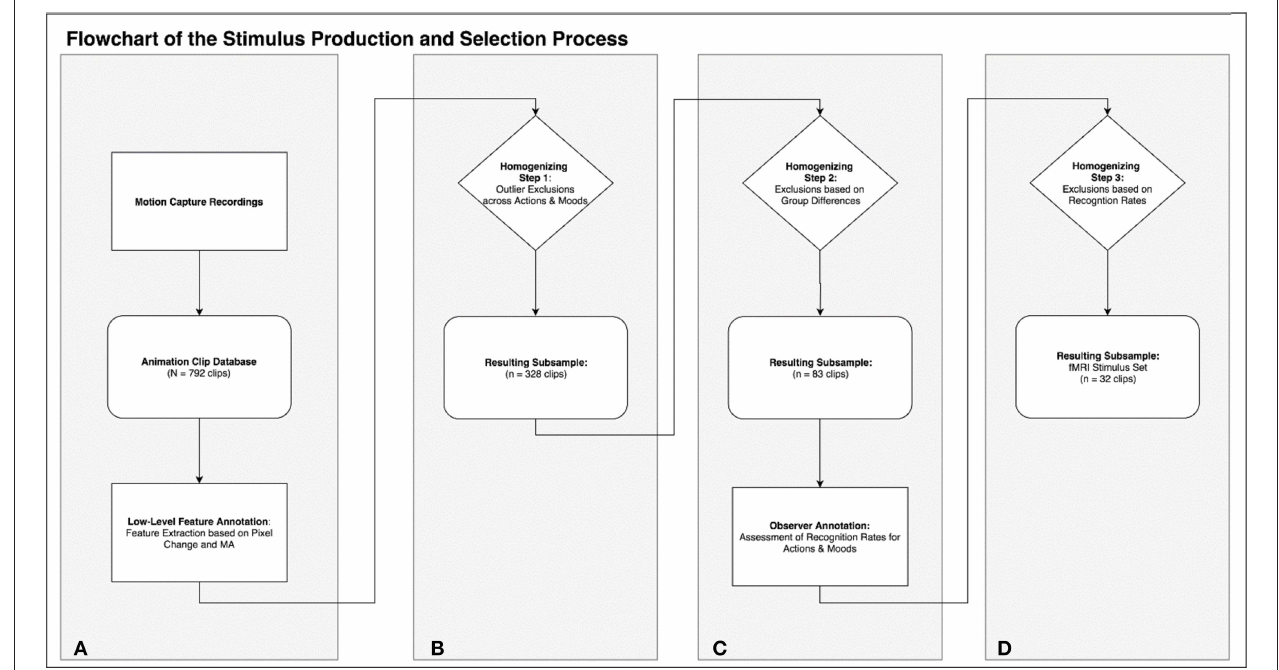
FIGURE 1 | This flowchart summarizes the rationale and process of stimulus production (A) , annotation (A,C) , and selection of the stimulus subsets (B–D)